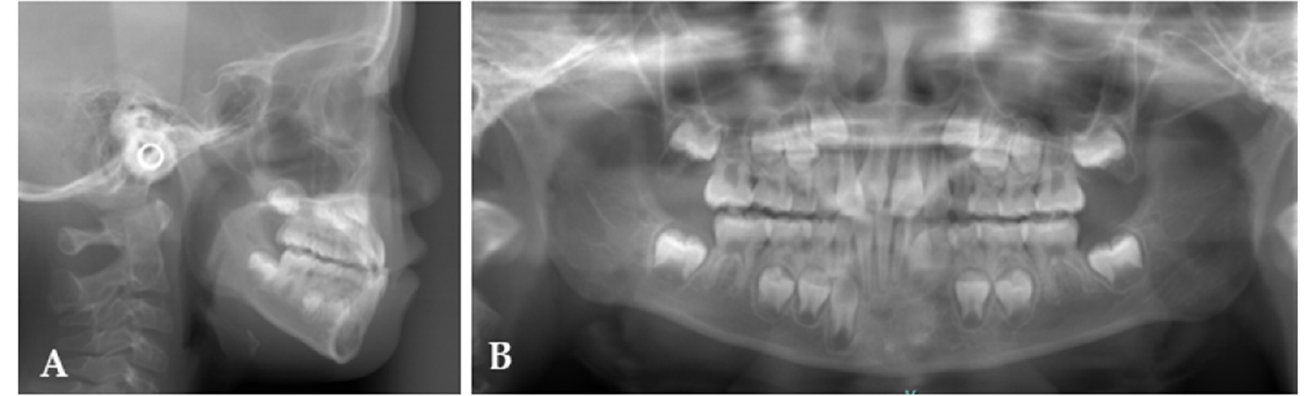
Figure 2. Pretreatment lateral cephalogram ( A ) and panoramic radiograph ( B